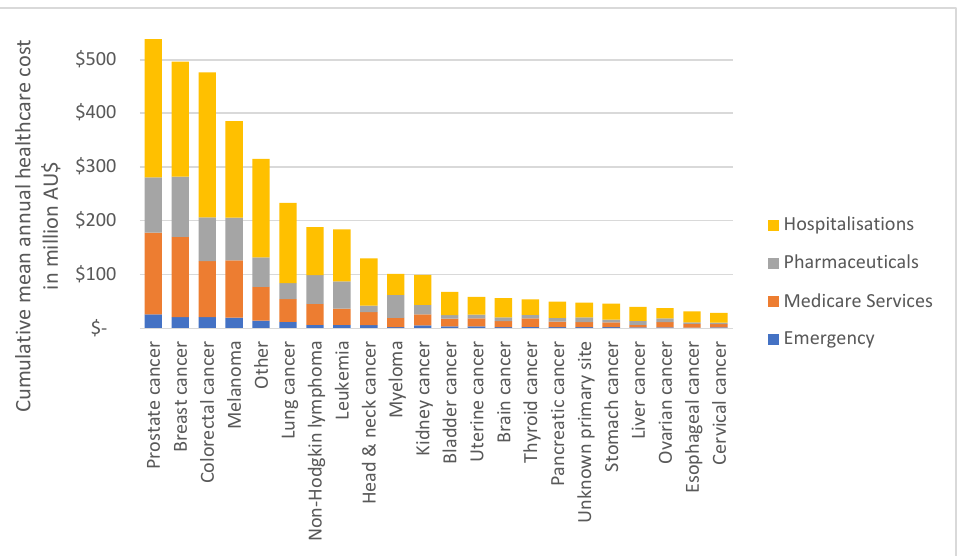
Figure 8. Cumulative mean annual healthcare cost (2013–2016) in AU$ for the cancer cohort by type of cancer and health service component (N =